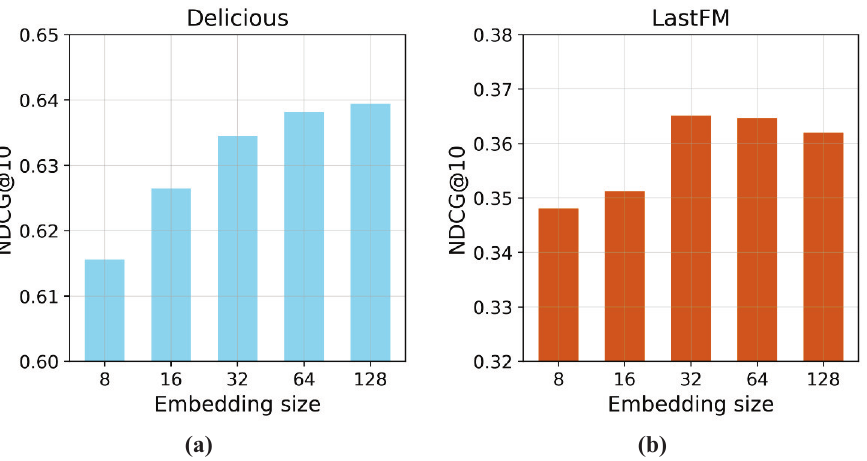
Figure 6. Recommendation results of different embedding sizes. ( a ) NDCG@10 on Delicious. ( b ) NDCG@10 on